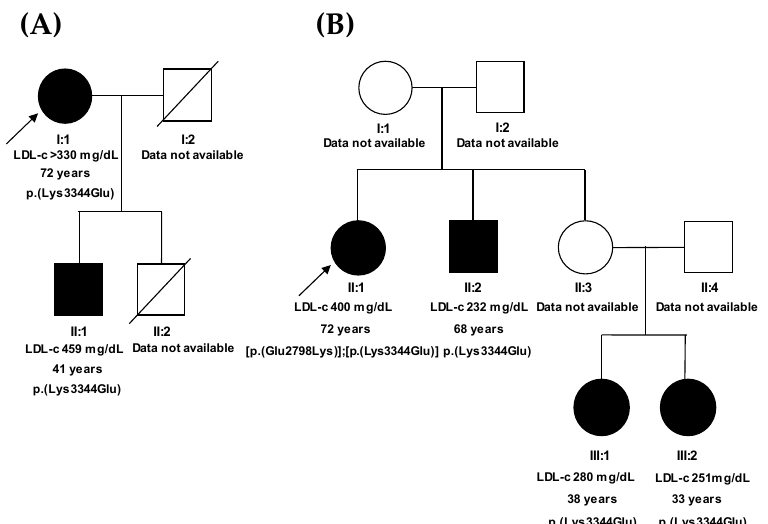
Figure 2. Pedigrees of the families of the 2 index patients carrying the apoB p.(Lys3344Glu) variant. The index cases are indicated with an arrow; circle and square symbols represent women and men, respectively; and shadow-filled symbols indicate the members affected with FH. The first line below the symbols corresponds to the individual identi fi cation, the second indicates LDL-c levels before lipid-lowering therapy, the third indicates age, and the fourth indicates the amino acid change in apoB. ( A ) Pedigree of the family of patient 1. ( B ) Pedigree of the family of patient 2. No relatives of any index patient carrying the apoB p.(Ser3801Thr) variant were avail- able for the co-segregation analysis of this variant.